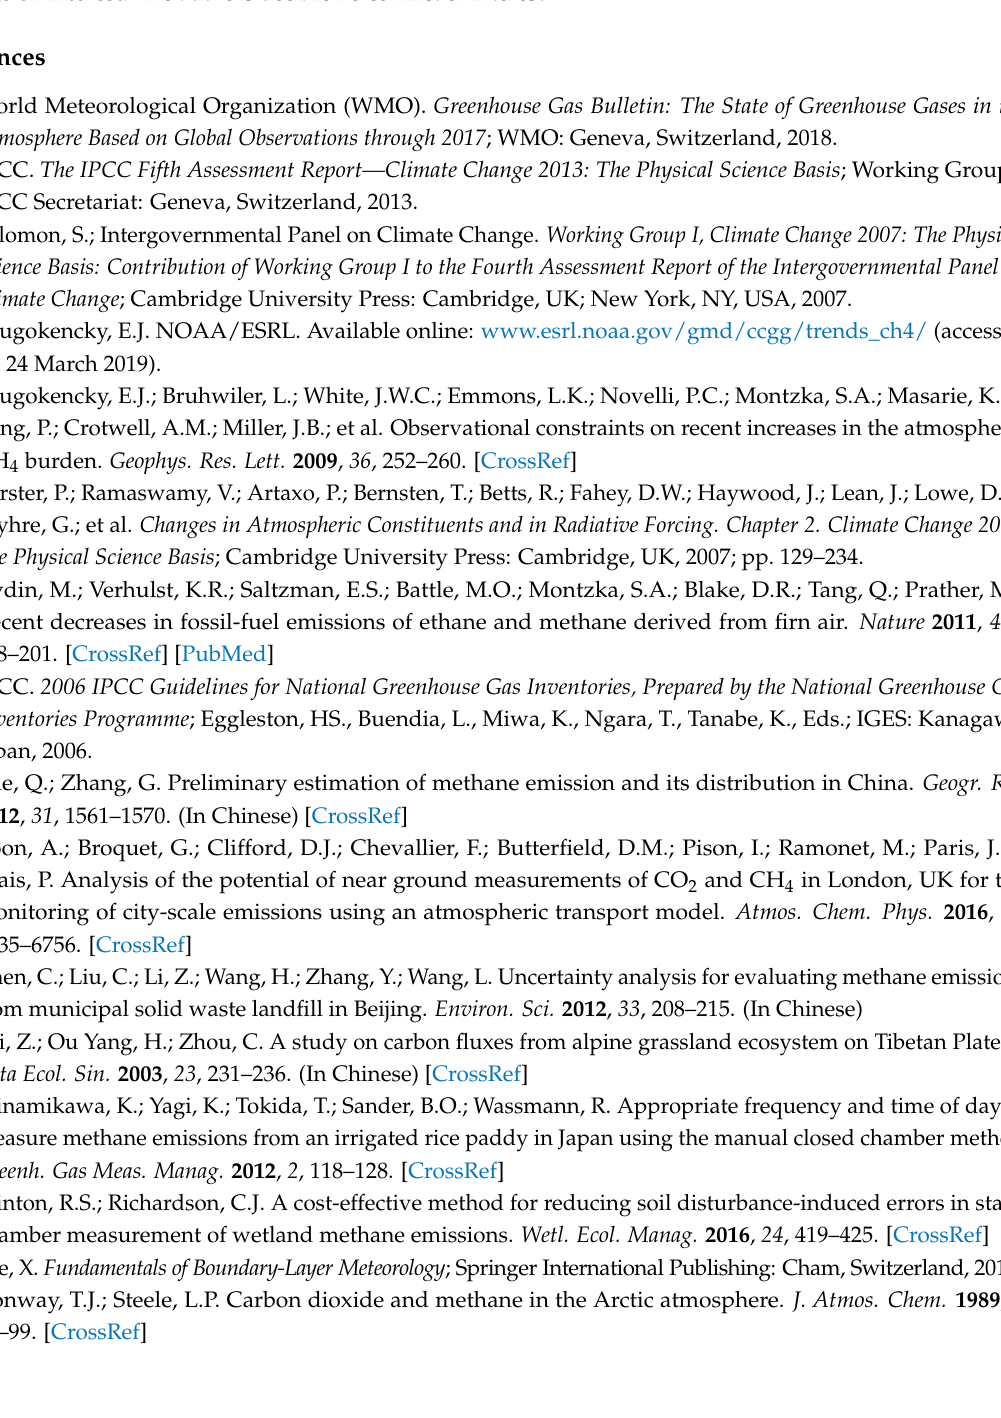
different regions, Table S1: Summary of CH 4 /CO 2 emissions ratio (ppb/ppm) estimated with the atmospheric method found in the literature. Supplementary data file is available at: https://yncenter.sites.yale.edu/data-